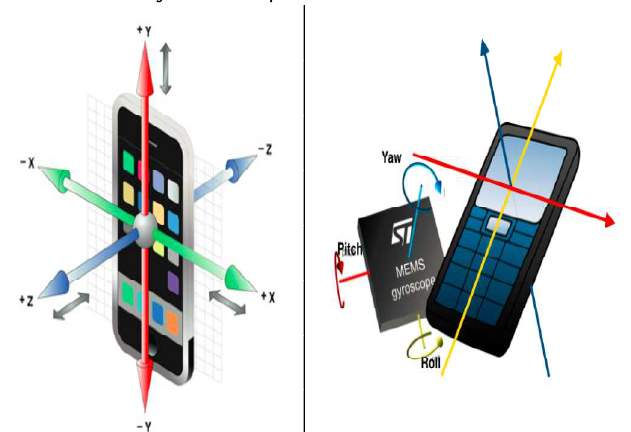
Figure 1: Accelerometer and Gyroscope